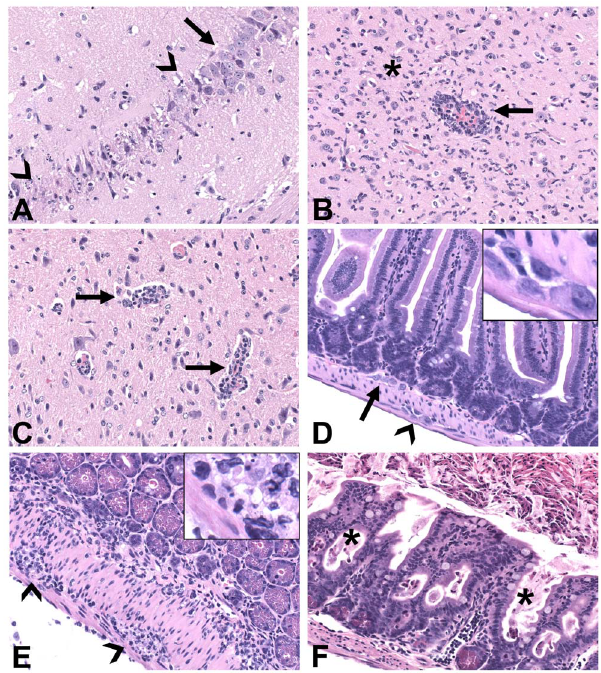
Figure 6. More severe histopathologic lesions were apparent in the brains and gastrointestinal tracts of KFDV-infected mice than AHFV-infected mice. (A) Brain, hippocampus, KFDV-infected mouse, 6 dpi; acute necrosis and loss of hippocampal neurons (segment delineated by arrowheads), with adjacent, relatively unaffect- ed neurons (arrow). (B) Brainstem, KFDV-infected mouse, 6 dpi; severe meningoencephalitis with perivascular cuffing (arrow) and widespread gliosis in the adjacent neuropil (asterisk). (C) Brainstem, AHFV-infected mouse, 7 dpi; mild meningoencephalitis characterized by perivascular cuffing (arrows). (D) Small intestine, mock-inoculated mouse; normal tissue section demonstrating anatomic location of submucosal (arrow) and myenteric (arrowhead) nerve plexi and normal intestinal villi; inset shows higher magnification of neuron cell bodies in plexus. (E) Small intestine, KFDV-infected mouse, 7 dpi; moderate, predominantly histiocytic, inflammatory infiltrate in submucosa and muscularis, involving and disrupting myenteric plexi (arrowheads). Inset shows higher magnification of infiltrate and cell debris in plexus. (F) Small intestine, KFDV-infected mouse, 7 dpi; intestinal crypts are dilated and filled with necrotic cells (asterisks), intestinal lumen contains abundant cellular debris (top of image), and villi are blunted and fused. All H&E images, original magnification